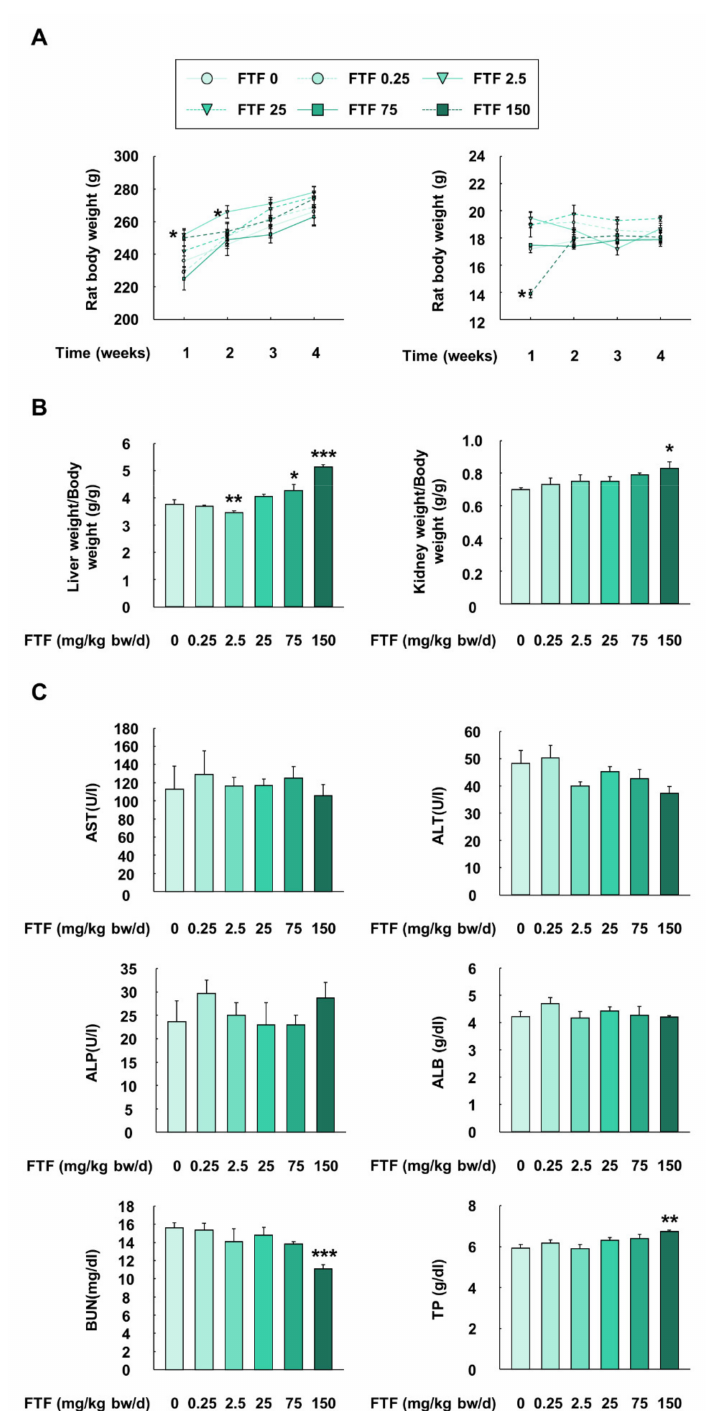
Figure 6. Effects of FTF on body weight, feed intake, organ weight, and biochemical profiles in female SD rats: ( A ) the change of body weight and feed intake in female SD rat; ( B ) liver weight/body weight and kidney weight/body weight in female SD rats; ( C ) plasma biochemical profiles including AST, ALT, ALP, ALB, BUN, and TP in female SD rats. Rats were administered FTF at 0, 0.25, 2.5, 25, 75, and 150 mg/kg bw/day for 28 days ( n = 3 animals per group). The results are expressed as mean ± SEM and statistically significant differences, as compared to the control (corn oil), are indicated as * P < 0.05, ** P < 0.01, and *** P < 0.001. Abbreviations: AST, aspartate aminotransferase; ALT, alanine aminotransferase; ALP, alkaline phosphatase; ALB, albumin; BUN, urea nitrogen; TP, total protein; SD, Sprague Dawley; FTF, flutriafol; SEM, standard error of